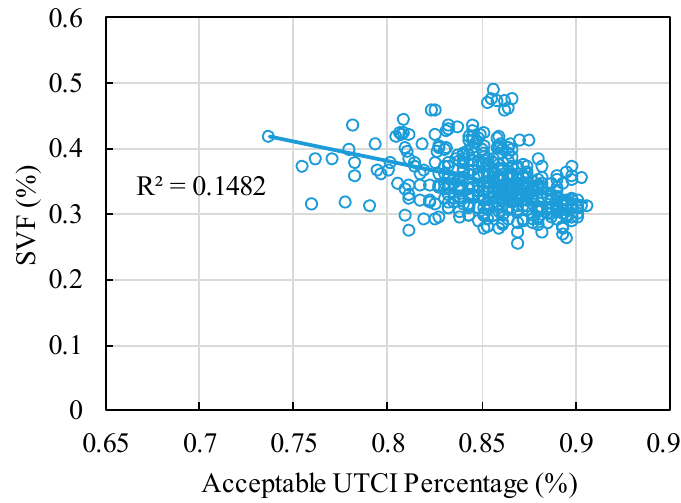
Figure 18. Correlation results of SVF and acceptable UTCI percentage at street level.